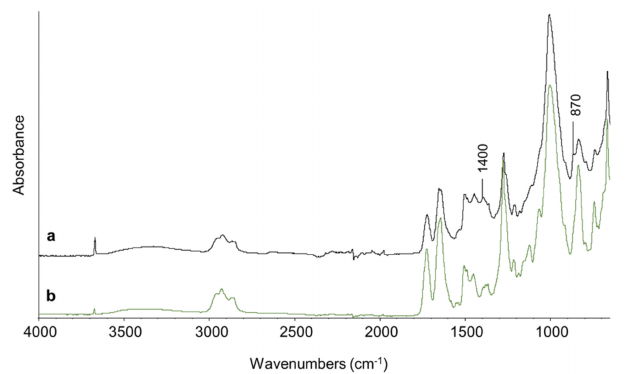
Figure 11. FTIR spectrum of the protected (wp) area of mock-up C treated with propylene carbonate, compared with the reference green alkyd spray. Labels in spectrum a show the absorptions due to the red styrene-acrylic residues. (a) C_IV_wp_wet; (b) reference green alkyd